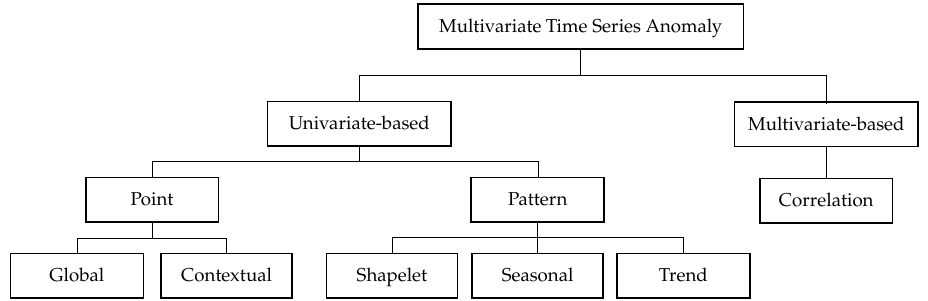
Figure 2. Anomaly types in multivariate time